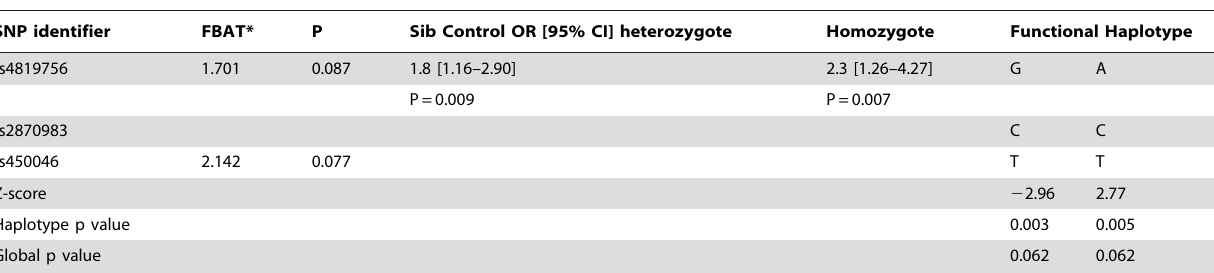
Table 2. Sibcentric